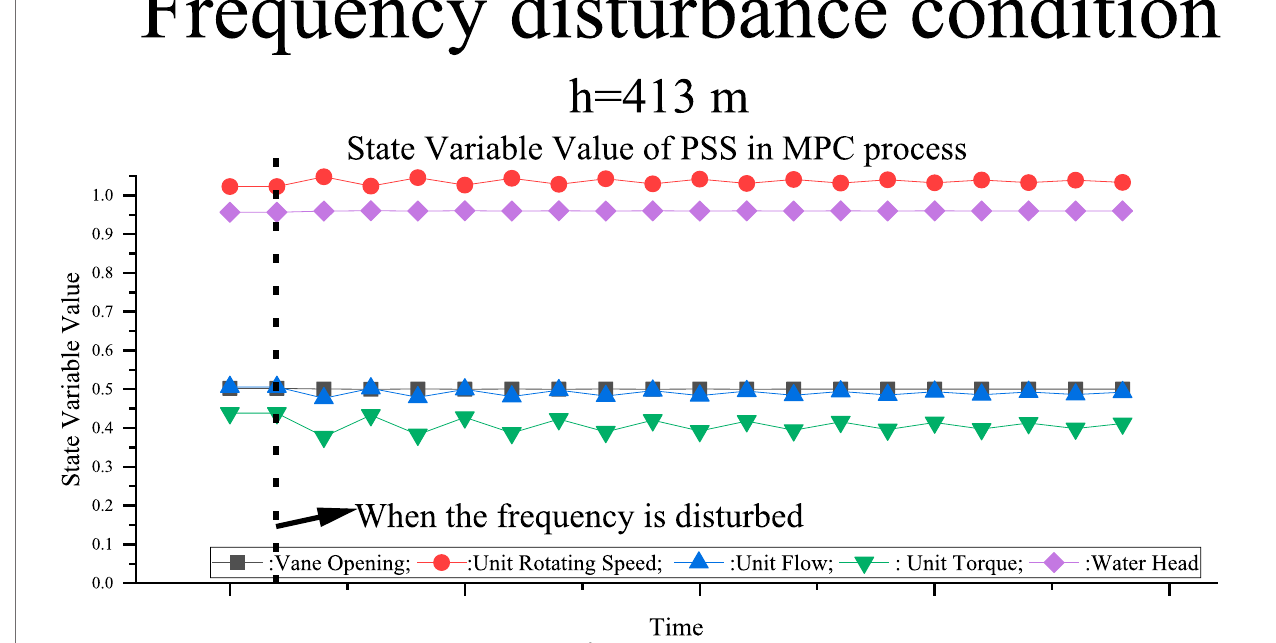
FIGURE 12 | PSS MPC state variables in the presence of a frequency disturbance under 413 and 418 m of water head.